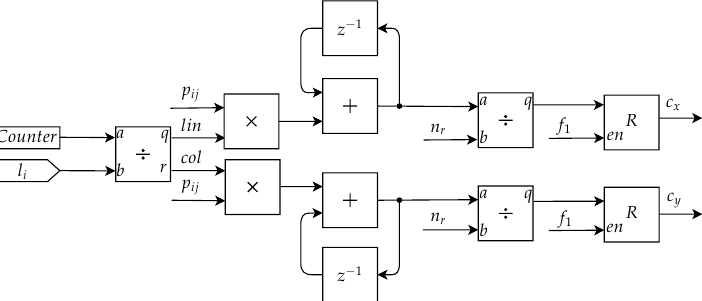
Figure 11. Architecture of the Symmetry Calculation Submodule responsible for calculating the center of